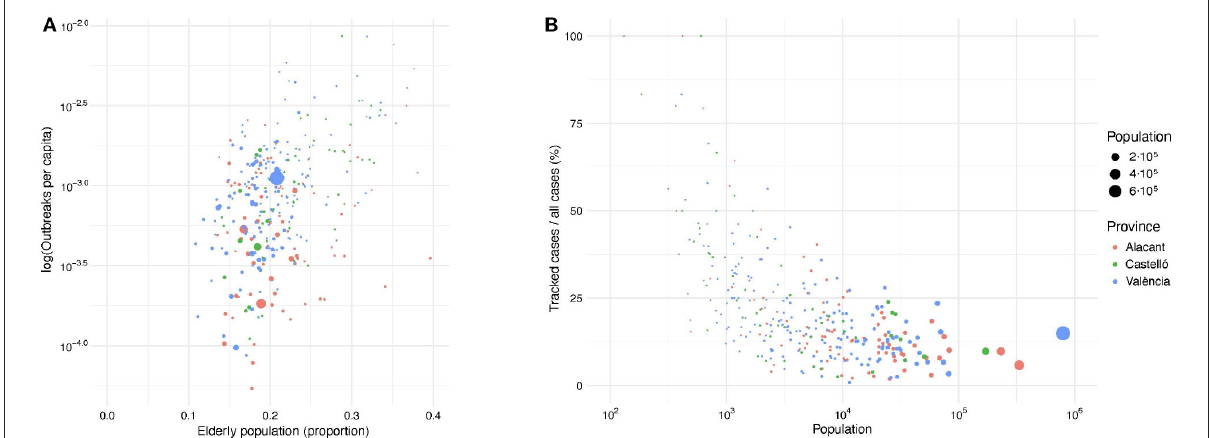
FIGURE4 (A) Relationship between the number of outbreaks per capita (in logarithmic scale) and the percentage of population above 65 years old in each municipality. (B) Relationship between the ratio of confirmed cases within tracked outbreaks and the total number of confirmed COVID-19 cases in each municipality. Dot size and dot color correspond to the municipality population and province, respectively.